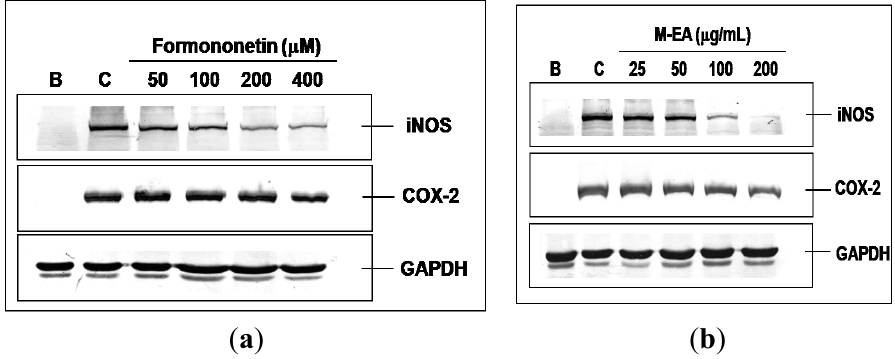
Figure 4. Dose responses orf formononetin ( a ) and M-EA ( b ) on iNOS and COX-2 expressions after LPS-activated RAW 264.7 cells. GAPDH was used as an internal control to identify equal amounts of protein loading in each lane. B: without LPS treatment, C: treatment with LPS and 0.2% DMSO. The results were detected from three separate experiments, from which one picture is shown.